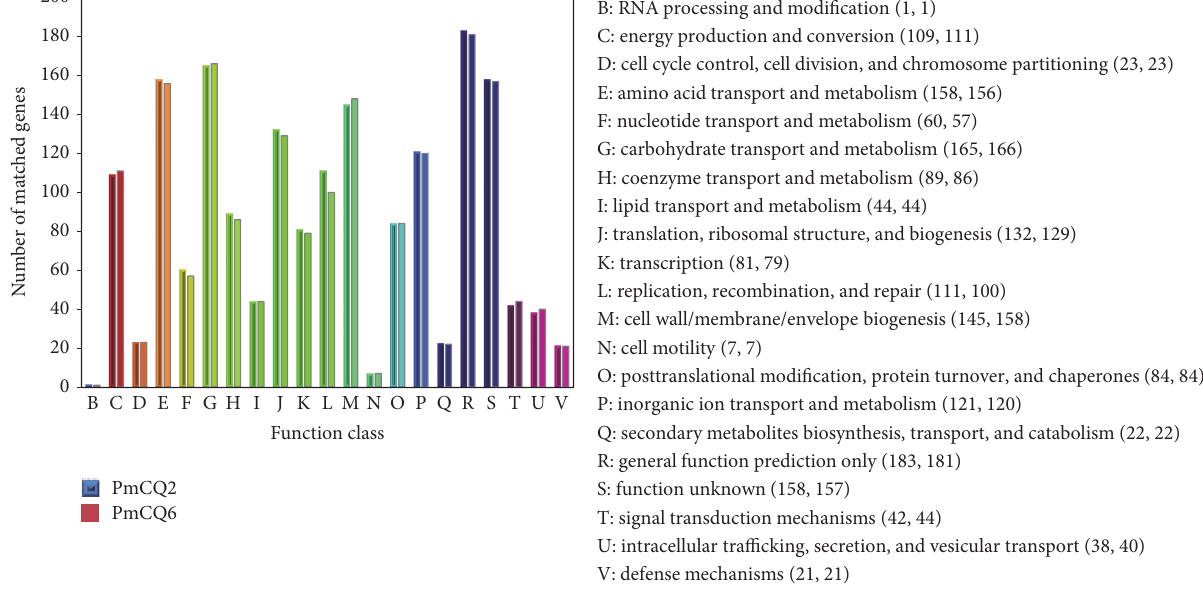
Figure 2: Clusters of Orthologous Group annotations for the genomes of PmCQ2 and PmCQ6. Arabic colon-separated numbers in brackets indicate matched proteins in PmCQ2 and